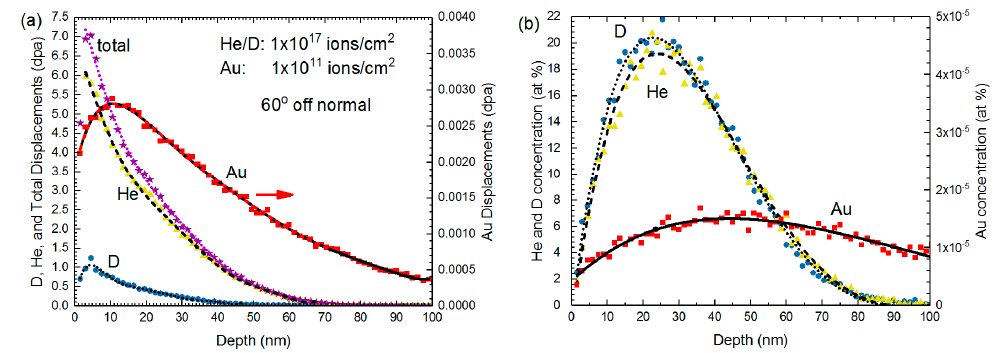
Figure 4. SRIM calculated ( a ) displacement and ( b ) concentration profiles as a function of depth for Au irradiated with various ion species, including 10 keV He, 5 keV D and 1.7 MeV self-ions. He and D ion fluence of 1 × 10 17 ions/cm 2 and Au fluence of 1 × 10 11 ions/cm 2 were used in the calculations. SRIM calculations are done at 60° off surface normal because the TEM specimen holder is tilted toward the ion beam. The total dpa profile (D + He + Au) is indicated by purple stars in (a); the Au profiles are indicated by red squares; He profiles are indicated by yellow triangles; and D profiles are indicated by blue circles. Lines of fit are only meant to guide the eye.